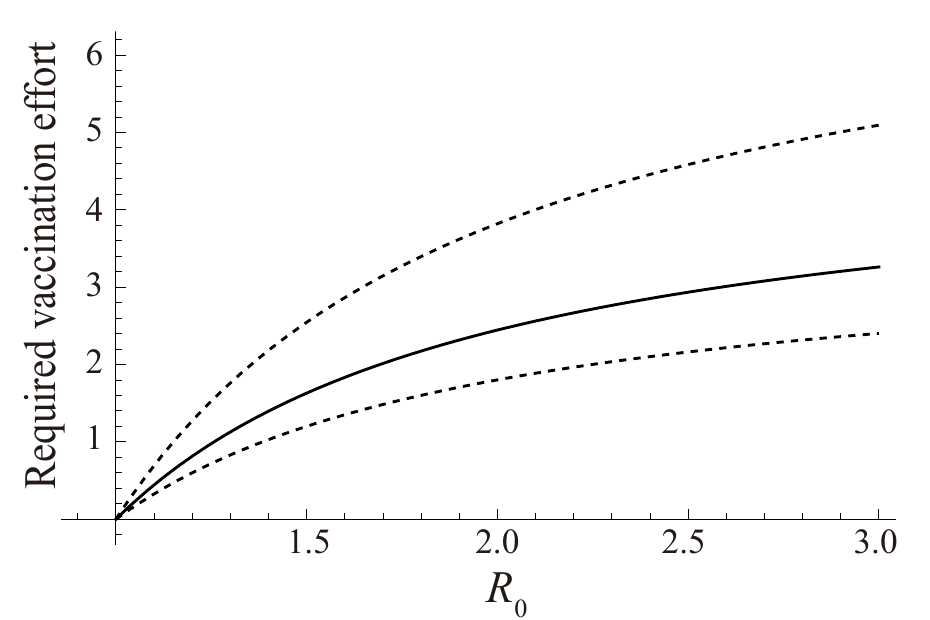
Fig 4. Required vaccination effort for CSF elimination at week 28 compared to the cumulative vaccination effort until week 50 [ V eff,i (50)] with a varied basic reproduction number. Mean estimated vaccination effort for the elimination of CSF is demonstrated by the solid line. The dashed lines denote 95% confidence intervals of the estimated values.